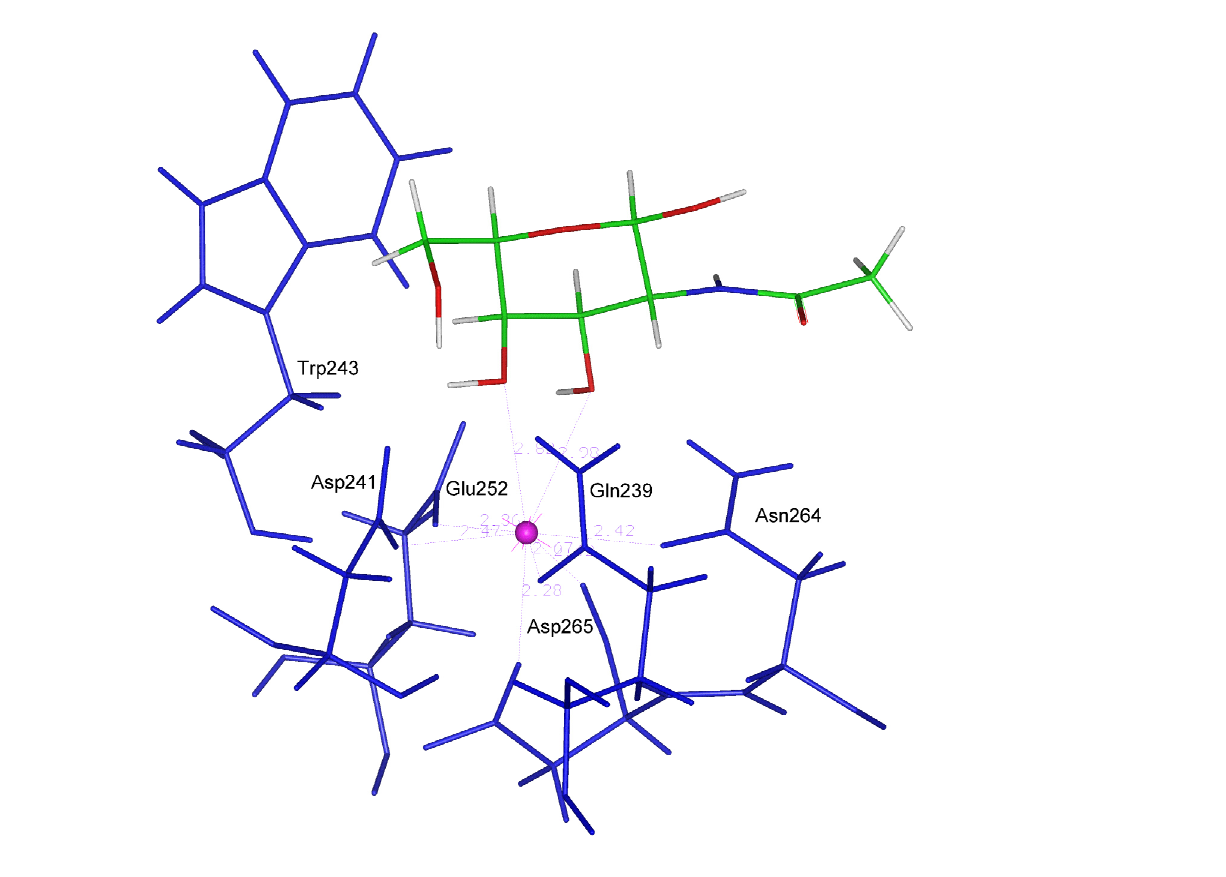
Figure 1. One of the three structure of NAG optimized in the binding